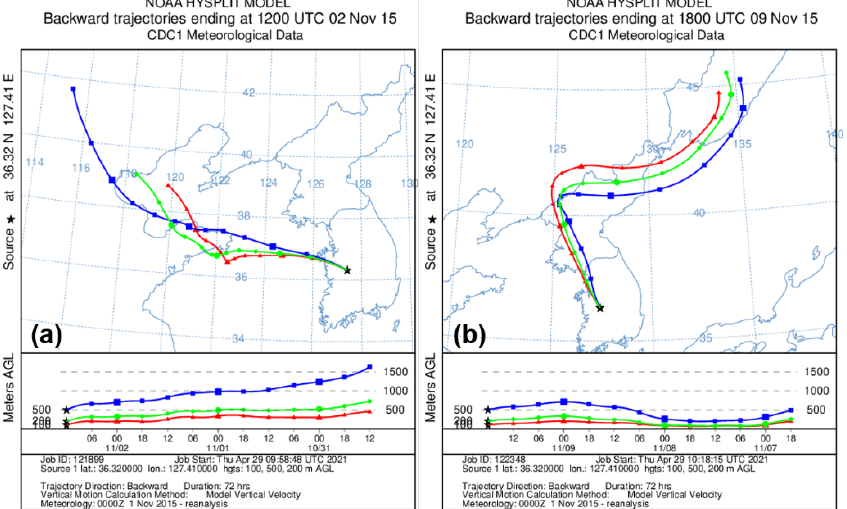
Figure 3. NOAA HYSPLIT 72-h backward trajectories ( a ) Case 1, 2 November 21:00 KST; ( b ) 10 November 03:00 KST, 2015.